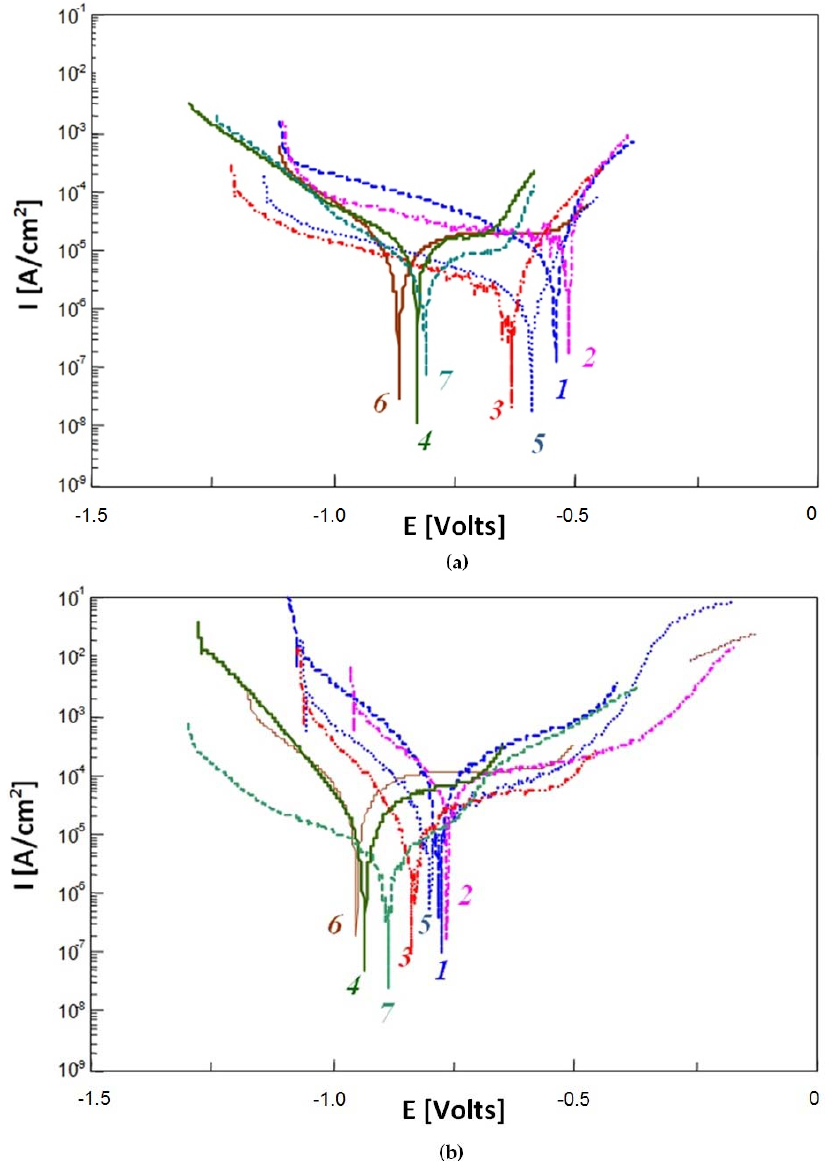
Figure 6. Polarisation curve for the alloys from 1 to 7 after: ( a ) 10 min and ( b ) 24 h of exposure in 3% aqueous solution of NaCl.